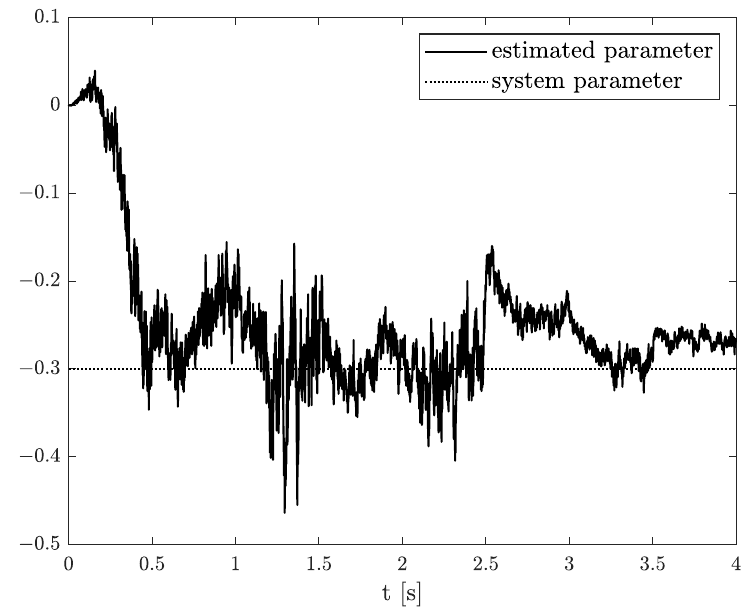
Figure 13. Original and estimated parameters from Example